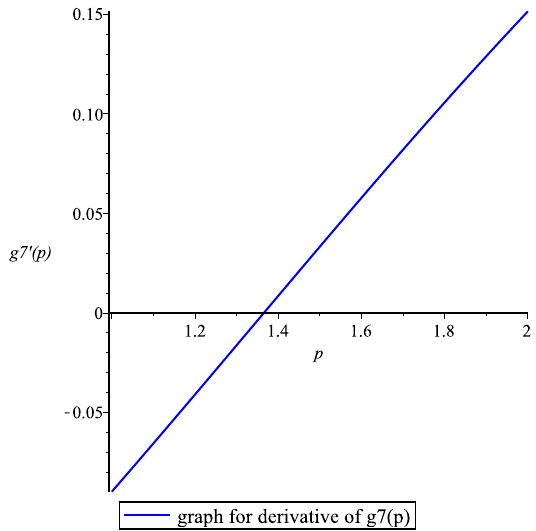
Figure 4. Graph for derivative of g 7 ( p )